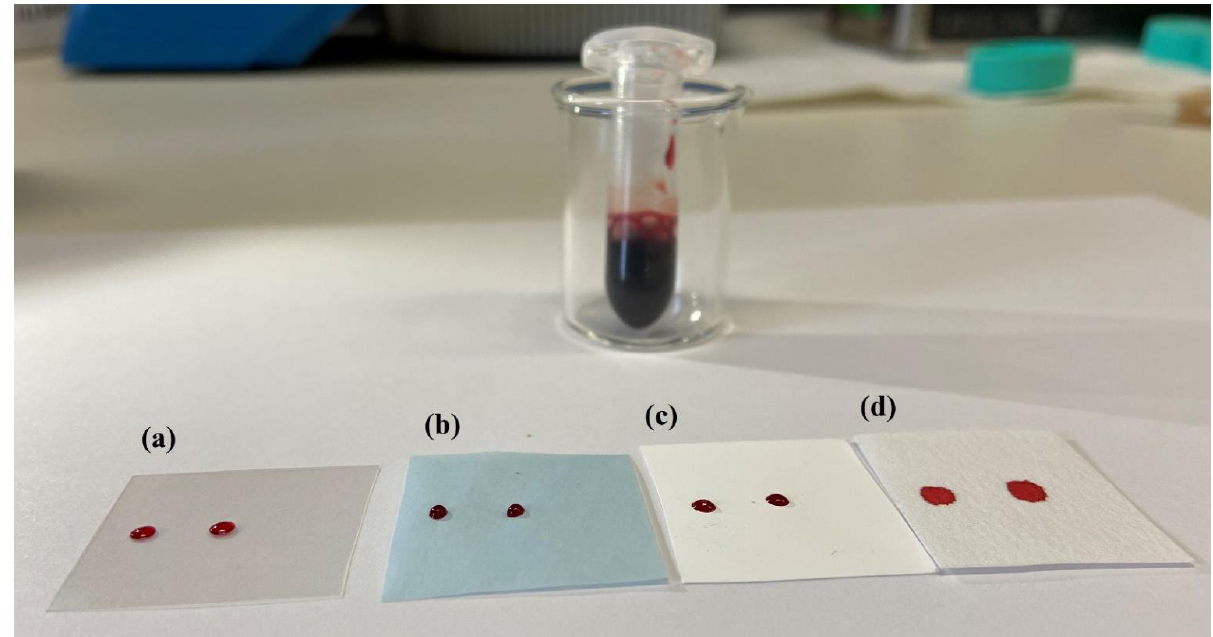
Figure 4. Comparison of the different behaviors of the same volume of whole blood (2 µ L) on different surfaces. Substrate ( a , b ) are acetate film and wax paper, respectively; ( c , d ) are cellulose mixed ester and bench paper